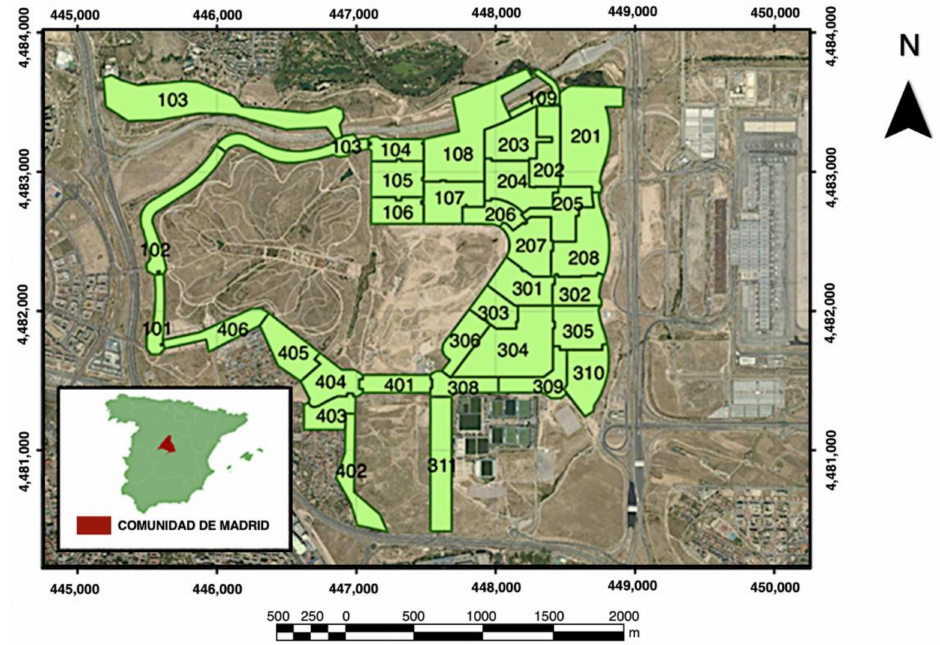
Figure 2. Codes and location of parks across the Valdebebas urban development. (Source: Valdebebas design